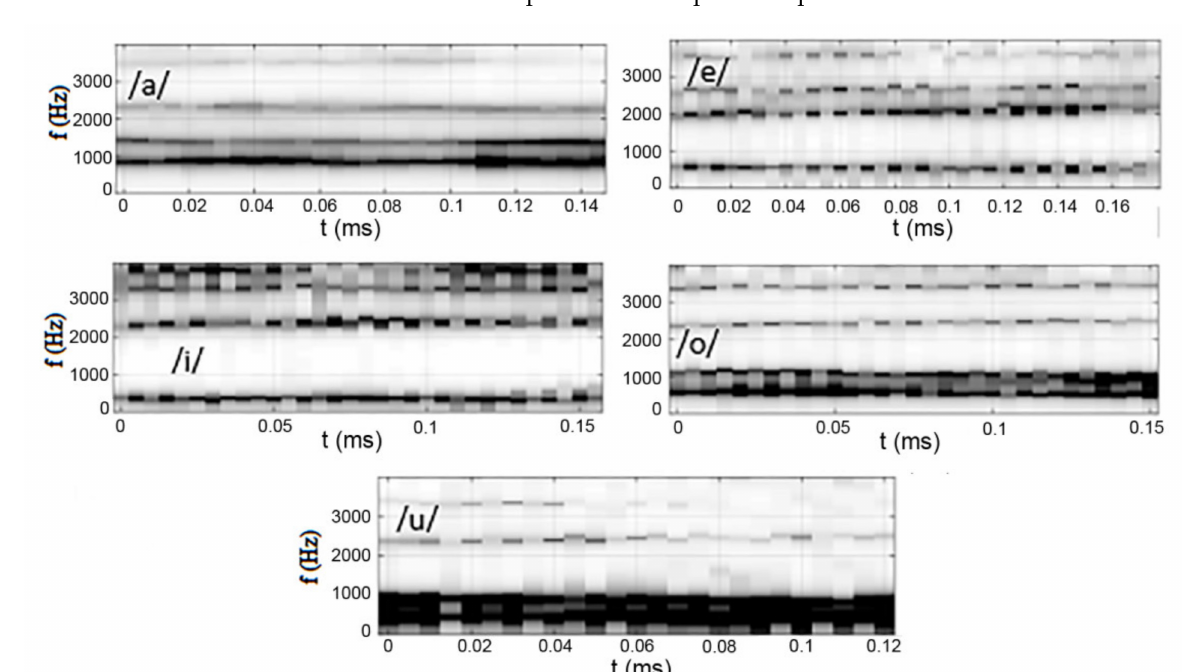
Figure 2. Hispanic vowel cochleograms for a male